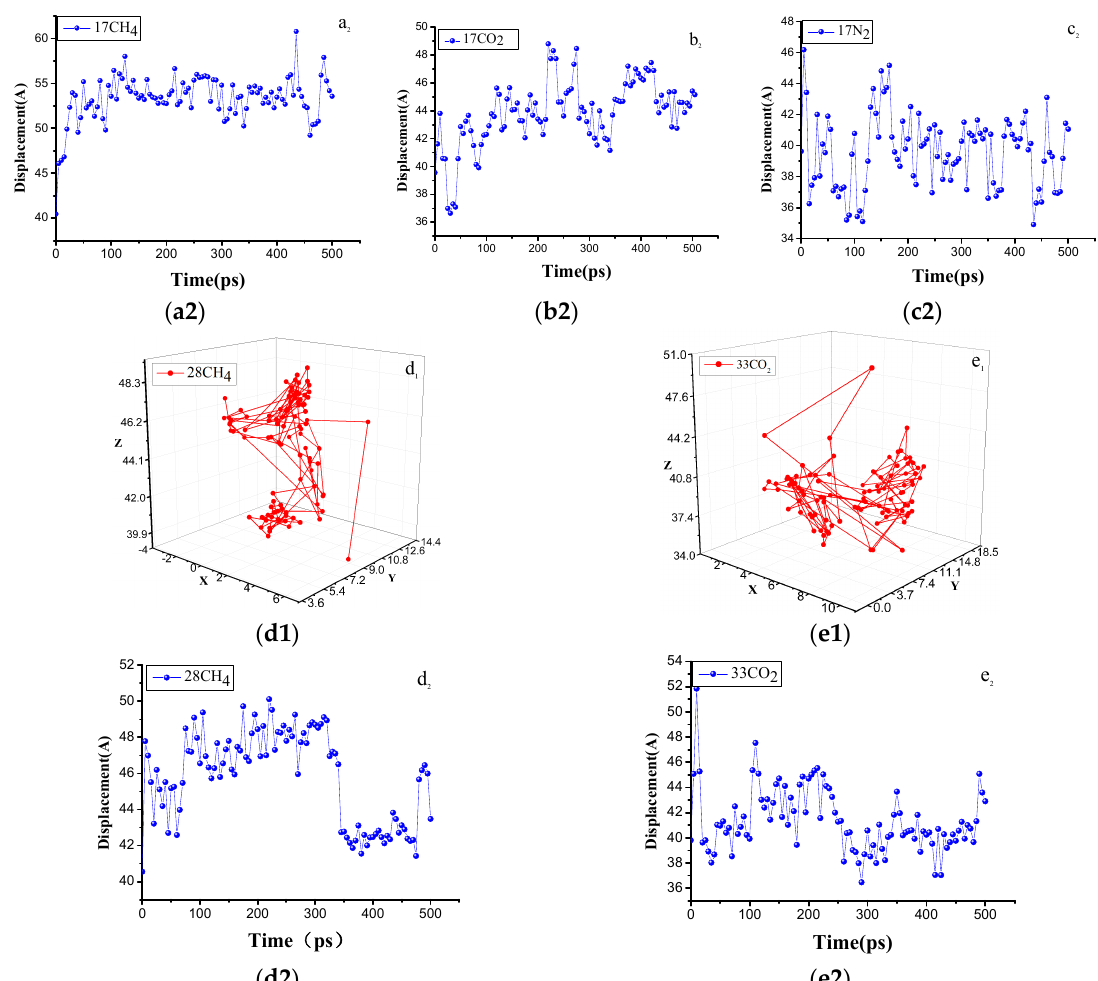
Figure 11. Diffusion trajectories and displacements of CO 2 , CH 4 , and N 2 . ( a1 ) the diffusion trajectory Figure 11. Di ff usion trajectories and displacements of CO 2 , CH 4 , and N 2 . ( a1 ) the di ff usion trajectory of 17CH. ( a2 ) the diffusion displacement of 17CH 4 . ( b1 ) the diffusion trajectory of 17CO 2 . ( b2 ) the of 17CH. ( a2 ) the di ff usion displacement of 17CH 4 . ( b1 ) the di ff usion trajectory of 17CO 2 . ( b2 ) the diffusion displacement of 17 CO 2 . ( c1 ) the diffusion displacement of 17 N 2 . ( c2 ) the diffusion di ff usion displacement of 17 CO 2 . ( c1 ) the di ff usion displacement of 17 N 2 . ( c2 ) the di ff usion trajectory trajectory of 17 N 2 . ( d1 ) the diffusion displacement of 28CH 4 . ( d2 ) the diffusion trajectory of 28 CH 4 . of 17 N 2 . ( d1 ) the di ff usion displacement of 28CH 4 . ( d2 ) the di ff usion trajectory of 28 CH 4 . ( e1 ) the ( e1 ) the diffusion displacement of 33 CO 2 . ( e2 ) the diffusion trajectory of 33 CO 2 . di ff usion displacement of 33 CO 2 . ( e2 ) the di ff usion trajectory of 33 CO 2